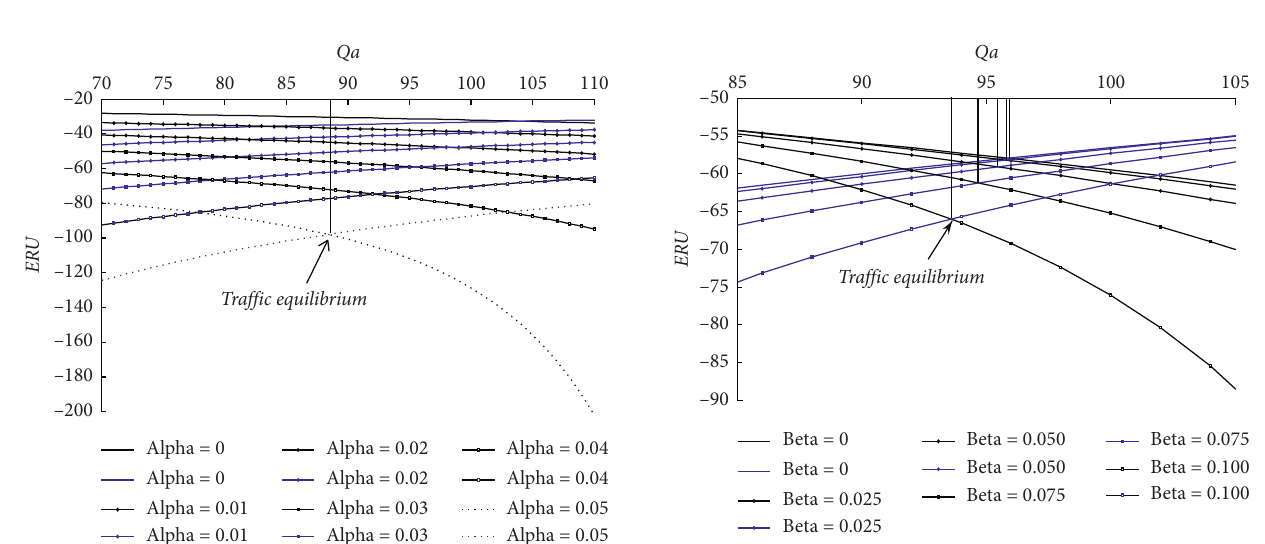
Figure 7: Influence of regret aversion parameters on traffic equilibrium. Note: the black line denotes route a , and the blue line denotes route b ; Q b � 200 − Q a